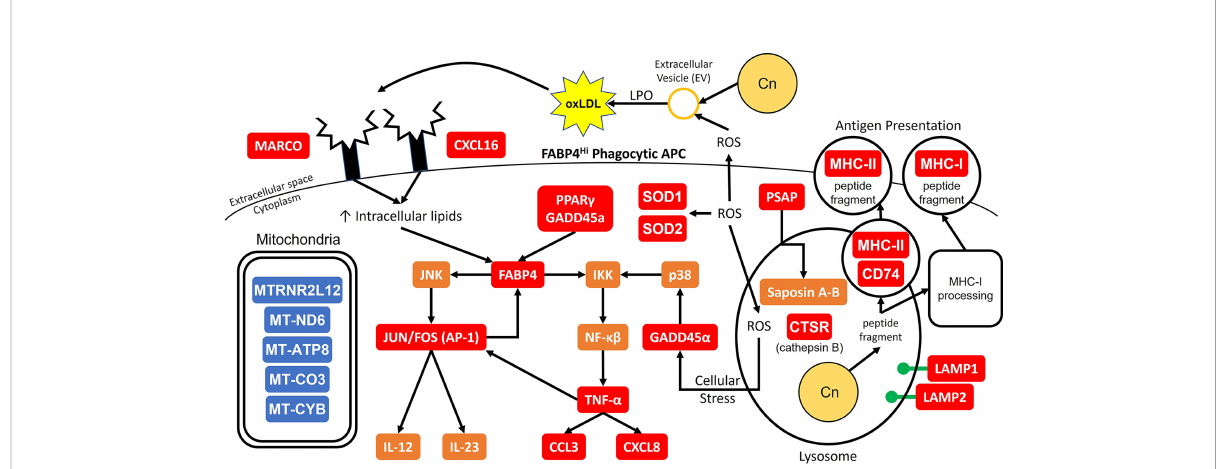
FIGURE 10 Model for Early Cryptococcal Interactions with Phagocytic APCs. Interactions of C. neoformans (Cn) with human pulmonary phagocytic APCs with high expression of FABP4 leads to downstream activation of genes including NF- kb and AP-1 and phagosome maturation, and down- regulation of many mitochondrial genes. Red and blue boxes indicate identi fi ed up- and down-regulated genes, respectively. Orange boxes indicate predicted